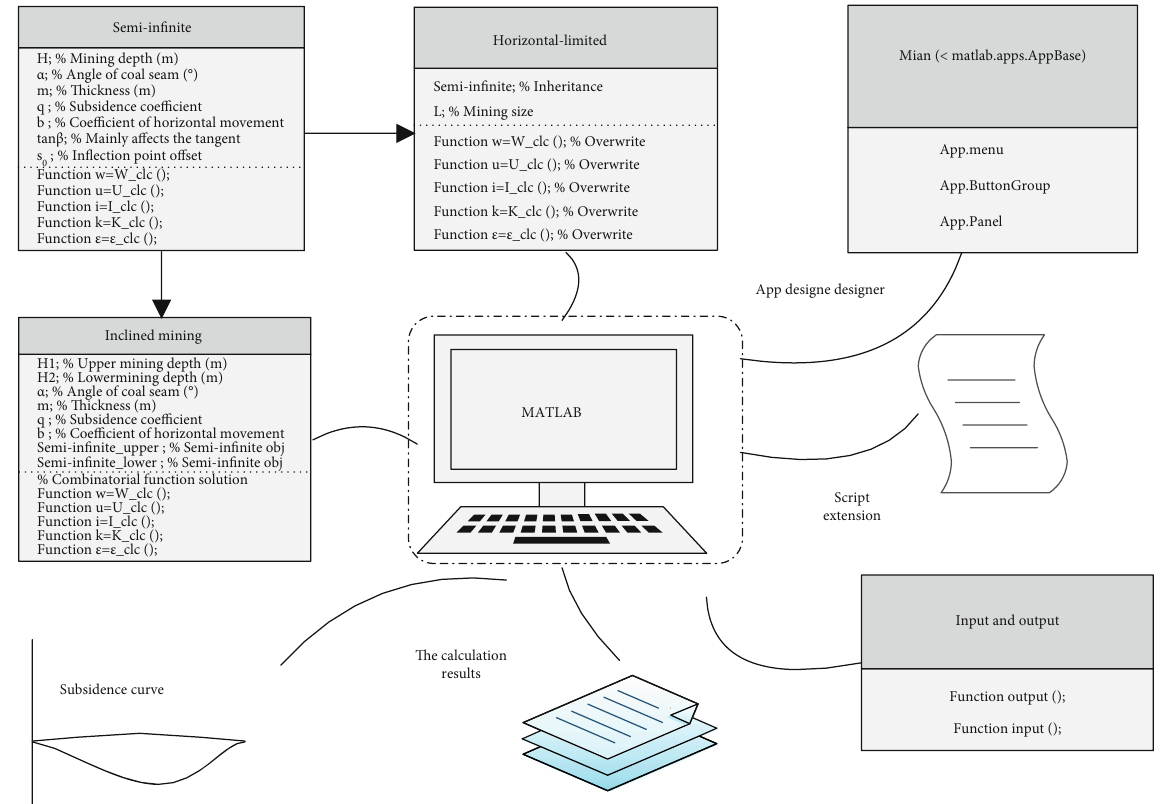
Figure 5: Research framework of object-oriented probability integration